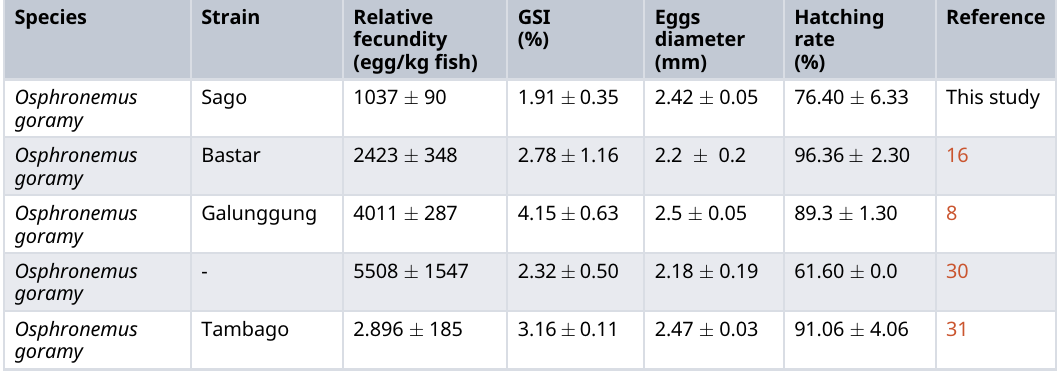
Table5.Summaryofthefecundity,gonadalsomaticindex,eggdiameter,andhatchingrateofgiantgourami.